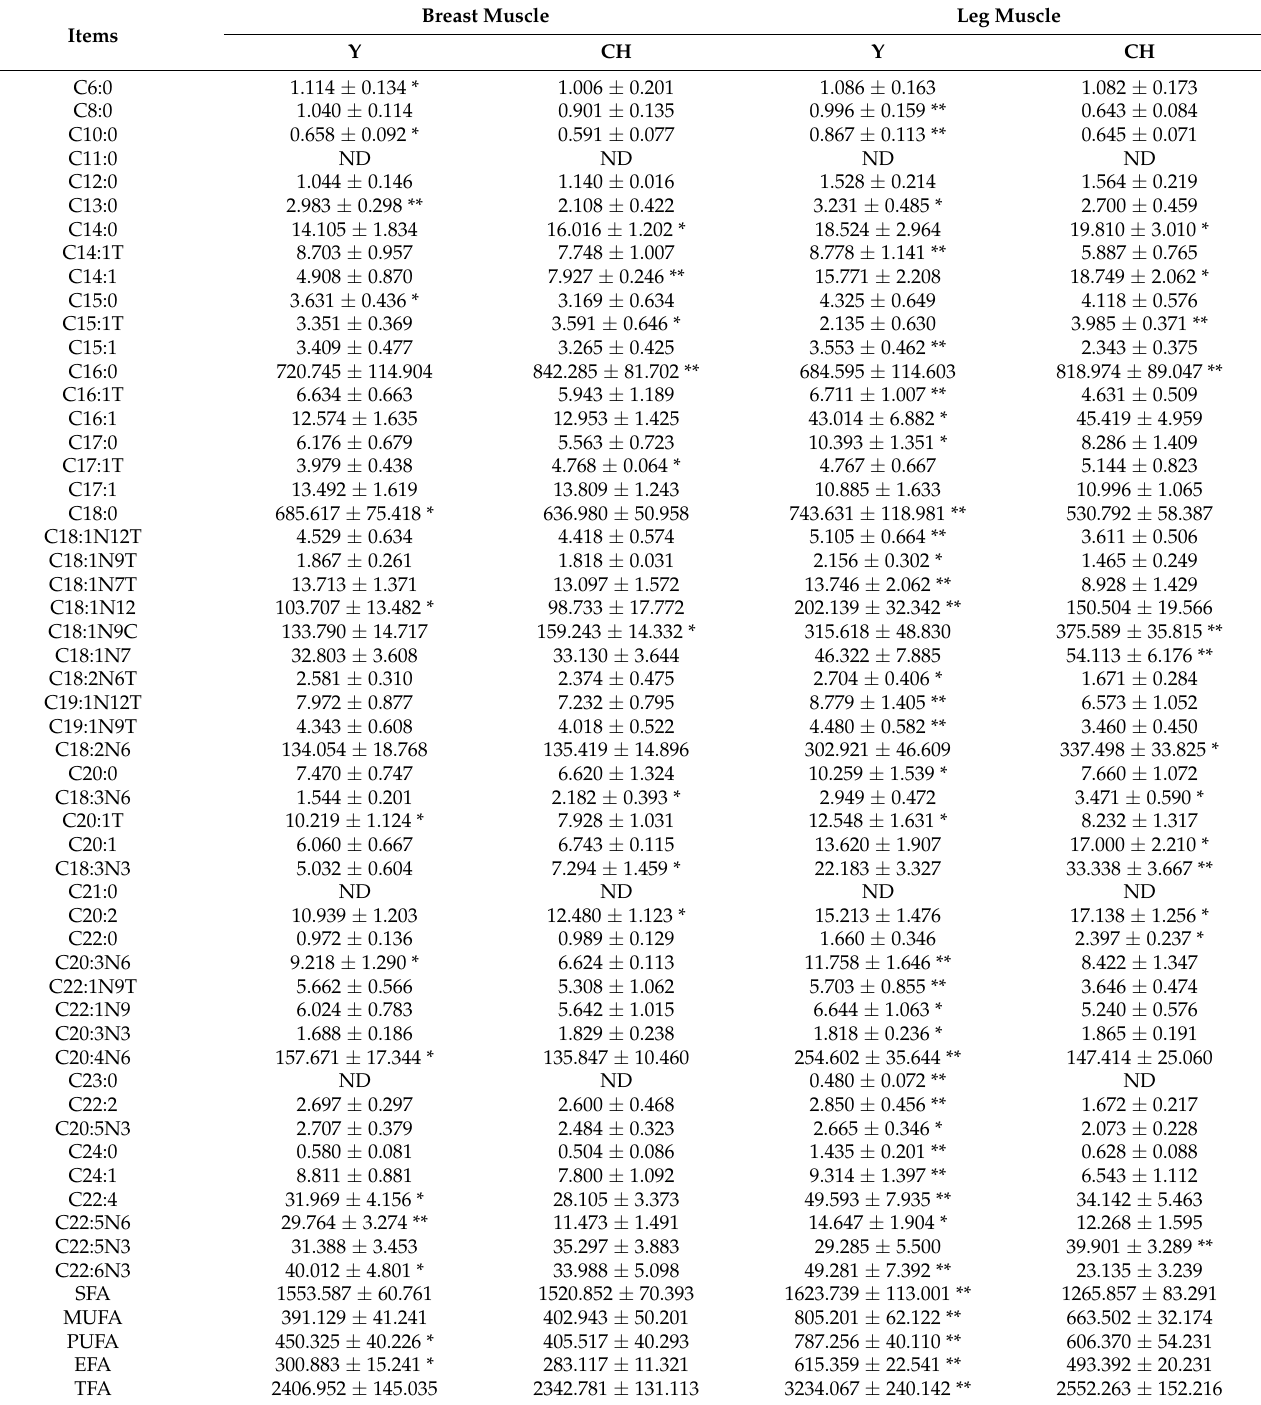
Table 4. Fatty acid content in muscles of